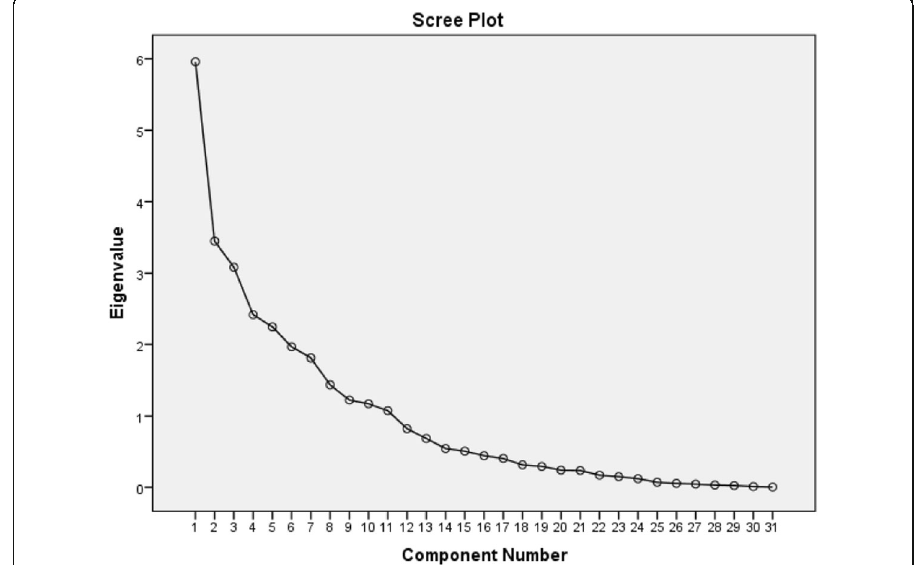
Fig. 2 Scree plot of the eigenvalues and the items of the